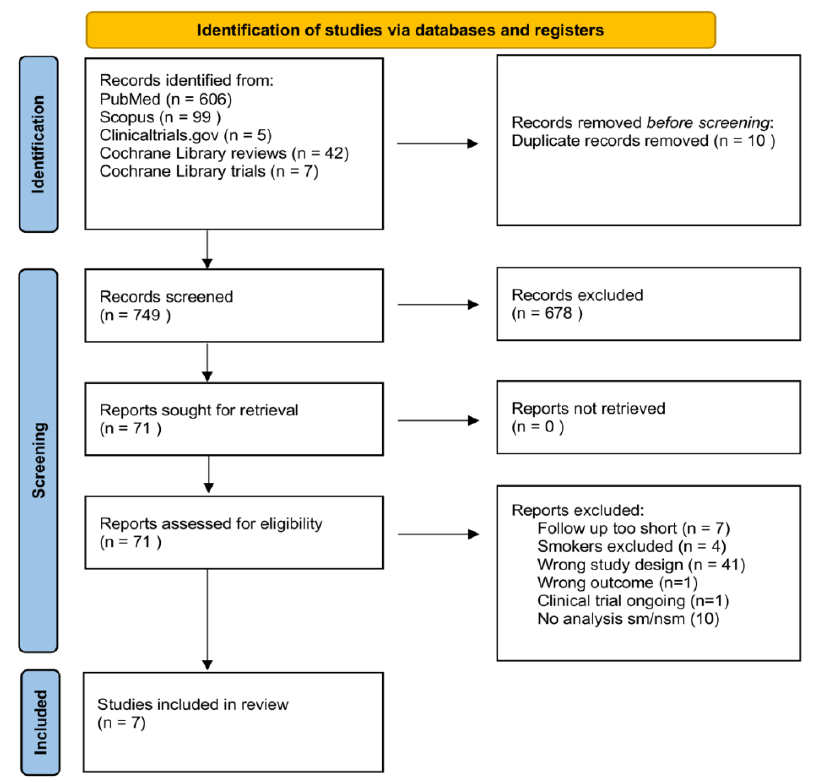
Figure 1. PRISMA flow diagram.